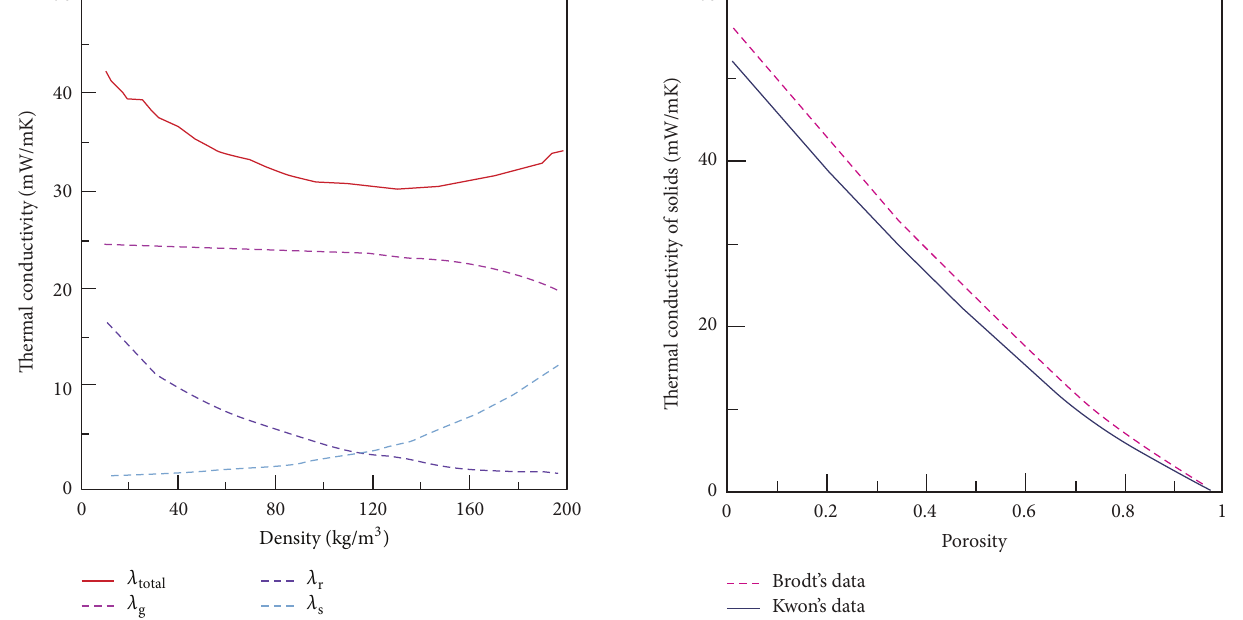
Figure 6: Comparison of the three heat transfer mechanisms in conventional thermal insulation materials [7].